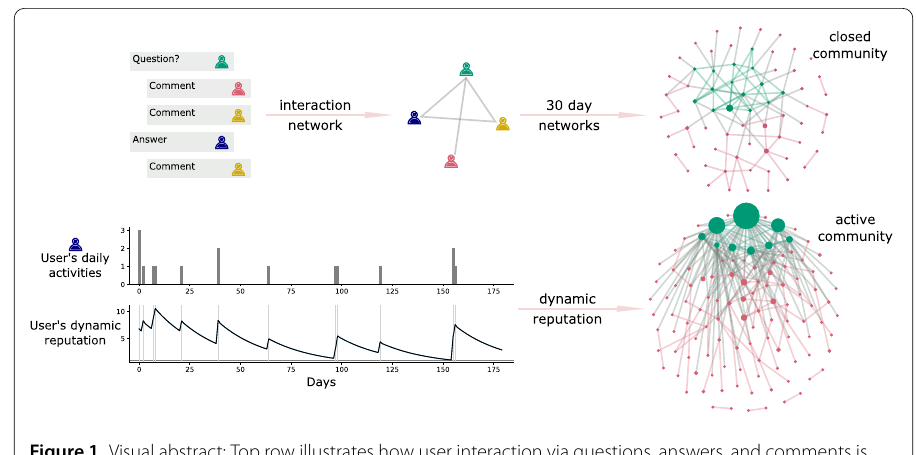
Figure 1 Visual abstract: Top row illustrates how user interaction via questions, answers, and comments is translated into an undirected network of interactions between users and finally aggregated over 30 day windows. The bottom row shows activity and corresponding dynamic reputation for one user from the closed Literature SE community. Networks on the right illustrate differences between closed and active SE Literature communities. Nodes are colored according to the core/periphery affiliation, while their size corresponds to dynamic reputation on the last day of interaction that the network contains